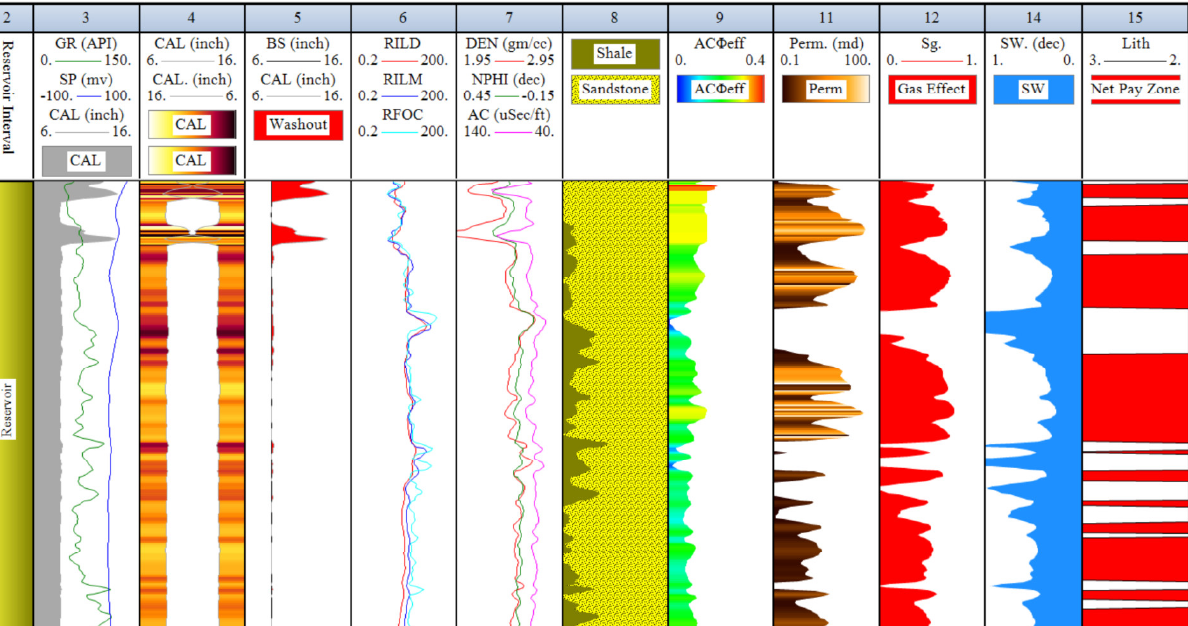
Figure 4. Litho saturation cross plot for YK18.